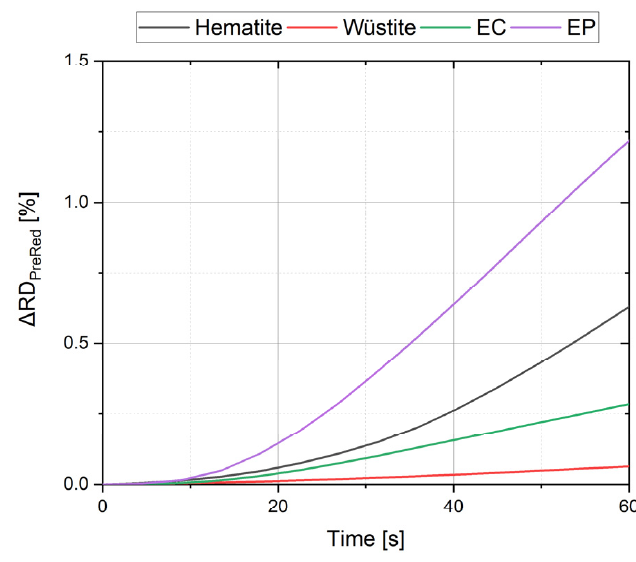
Metals 2023 , 13 , x FOR PEER REVIEW Figure 4. Change in the degree of reduction for the first minute within pre-melting.